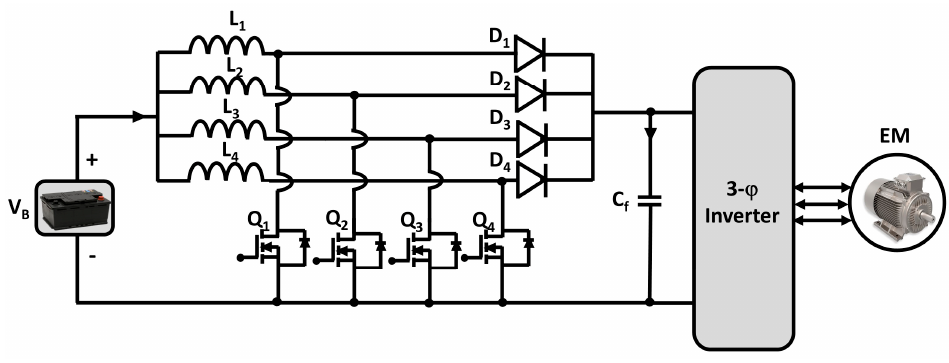
Figure 23. Four-phase Interleaved DC–DC Boost converter.